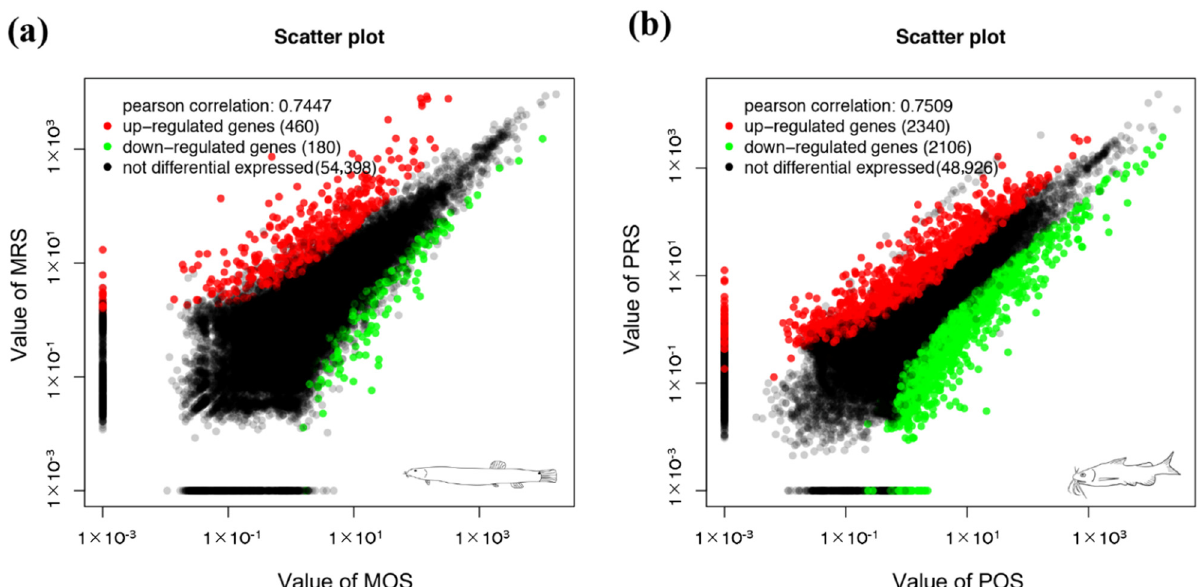
Figure 2. Scatter plot map for genes in comparisons of RS/OS pertain to loach ( a ) and yellow catfish ( b ). Each plot represents an individual gene. Red dots show up-regulated genes and green dots down-regulated genes in regenerated skin (FDR < 0.05, |log 2 FC(fold change)) >1). (a) (b)